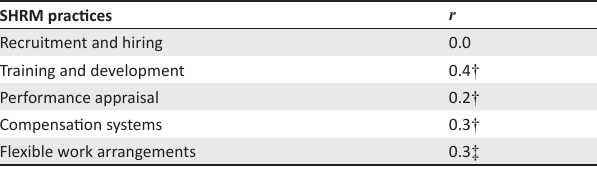
TABLE 1: Results of the correlation analysis for the relationship between SHRM practices and organisational performance